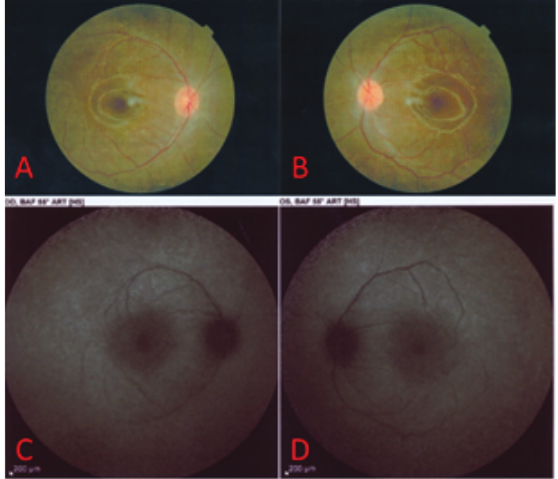
Figure 1. (A & B) Color fundus photograph shows optic disc pallor, vascular attenuation, and diffuse retinal atrophy with mottling of the retinal pigmented epithelium. (C & D) Perifoveal and perivascular hyperautofluorescence is noticeable on fundus autofluorescence